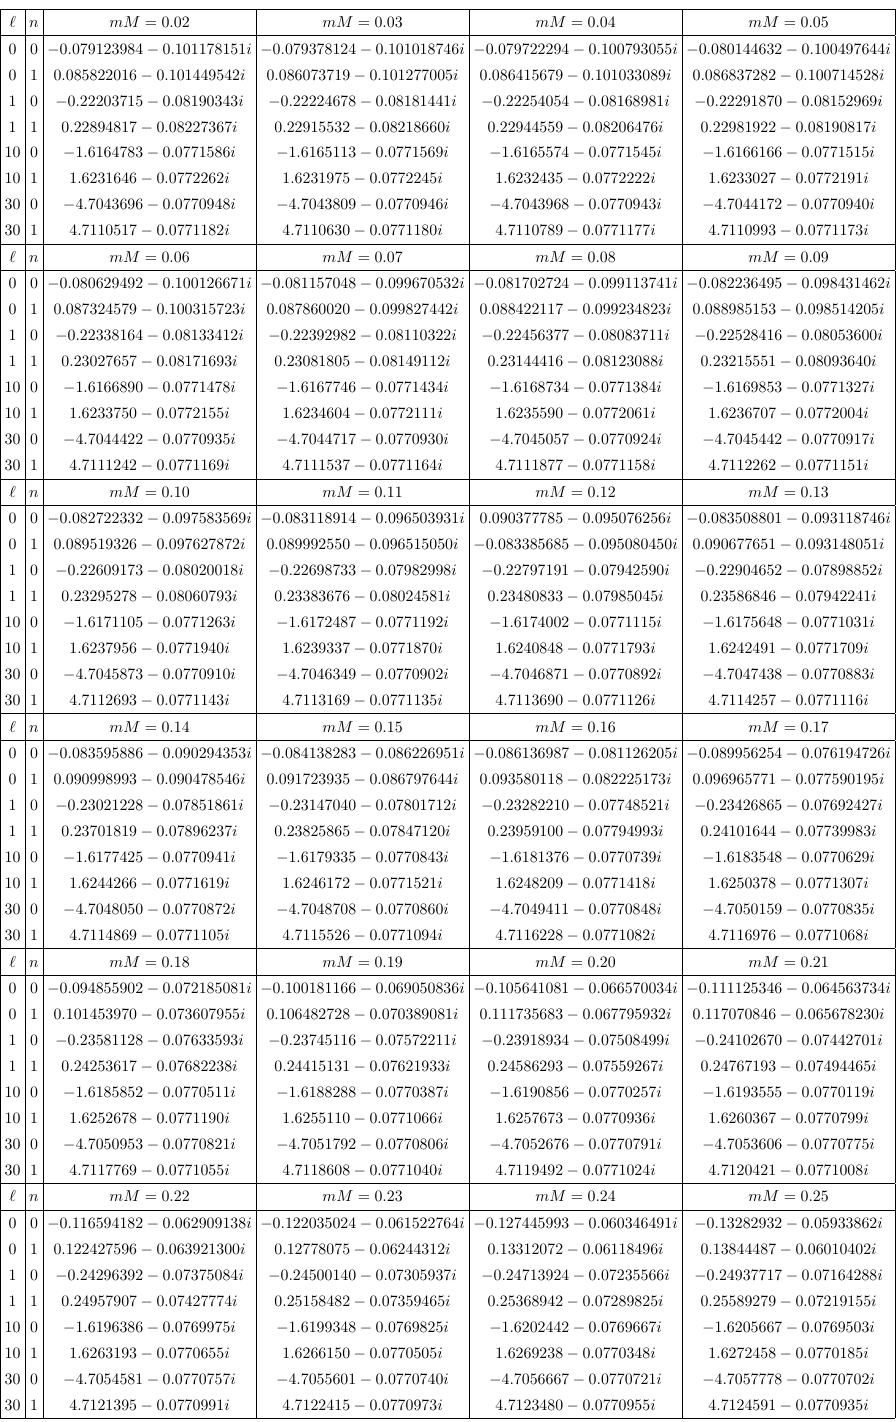
Table 9 . Dominant photon sphere QNFs ( ωM ) for massive scalar fields with qM = 0 . 10 , ‘ = 0 , 1 , 10 , and 30 in the background of a RNdS black hole with Λ M 2 = 0 . 04 , and Q/M = 0 . 1